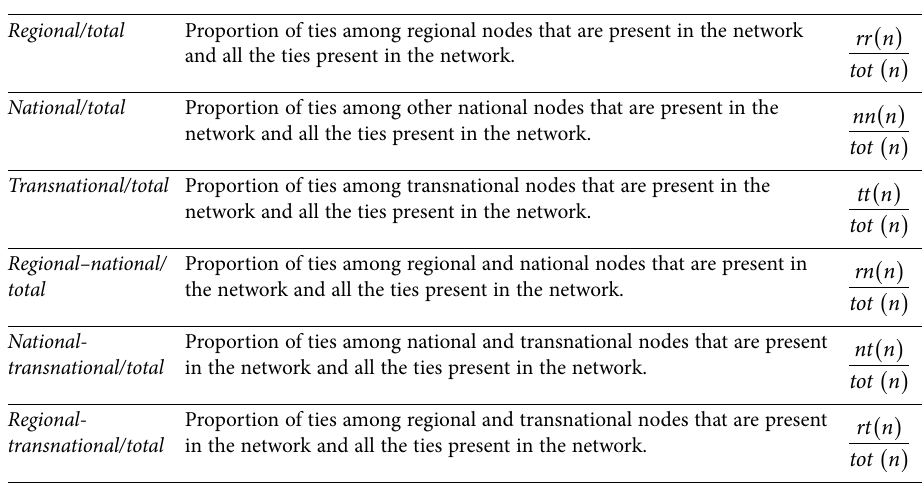
Table 4. Proportion of specific types of relations.